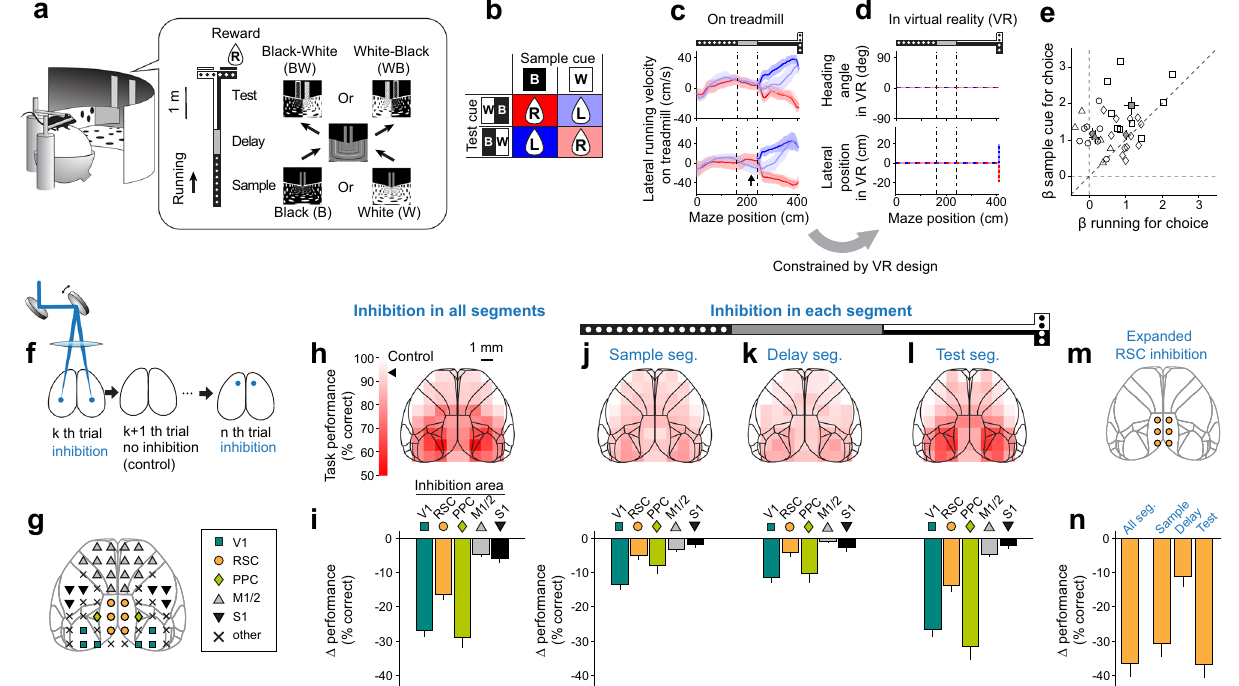
Fig. 1 | Optogenetics screen for cortical areas involved in a fl exible navigation task. a Schematic of experimental setup and delayed match-to-sample task. b Reward direction on each of the four trial types de fi ned by a combination of the sample cue and test cue. c Lateral running velocity of a mouse on the treadmill in two example sessions for four trial types colored asin panel ( b ).Shading indicates mean ± s.d. for correct trials. Prior to the test cue onset, trials with the black or white sample cue are colored by dark red and light blue, respectively. Arrow inthe bottom panel indicates a position inthe delaysegment wherethe velocity differed between trials with the black and white-sample cue. d Heading angle (top) and lateralposition(bottom)ofamouseinVRforfourtrialtypesshownasdashedlines and colored as in panel ( b ). e Logistic regression to explain the mouse ’ s choice based on the sample cue identity vs. running patterns in the delay segment. Beta coef fi cients from a single session are shown as an open symbol, with different shapes indicating sessions from different mice. Filled symbols with error bars indicate mean ± s.e.m. for each mouse. n =35 sessions from 4 mice. The data only includesessionsinwhichcalciumimagingdatawereacquiredfromposteriorbrain areas(V1,RSC,MM,A). f Schematicofoptogeneticinhibitionexperiments.Bilateral light was delivered randomly to one of 28 pairsof target sites and interleaved with control trials (no laser). g Colored symbols indicate grouping of inhibition sites based on cortical areas de fi ned in the Allen Mouse Brain Common Coordinate Framework 71 . h Task performance with inhibition throughout the trial for each corticallocation(bilateralinhibition).The locationof inhibition sitesisoverlaid on the cortical areal map based on the Allen Mouse Brain Common Coordinate Framework 71 .Theaverageperformanceincontroltrials(93.5±2.8%,mean±s.d.)is indicated by an arrowhead on the color bar. n =212±10 trials/site (mean ± s.d.), 265 sessions, and 7 mice. i Change in task performance with inhibition in all seg- ments (throughout the trial) relative to control trials. The change was computed fromthedatainpanel( h )andaveragedacrosssitesineachbrainarea,asmarkedin panel ( g ). Error bars indicate mean ± s.e.m. The performance signi fi cantly